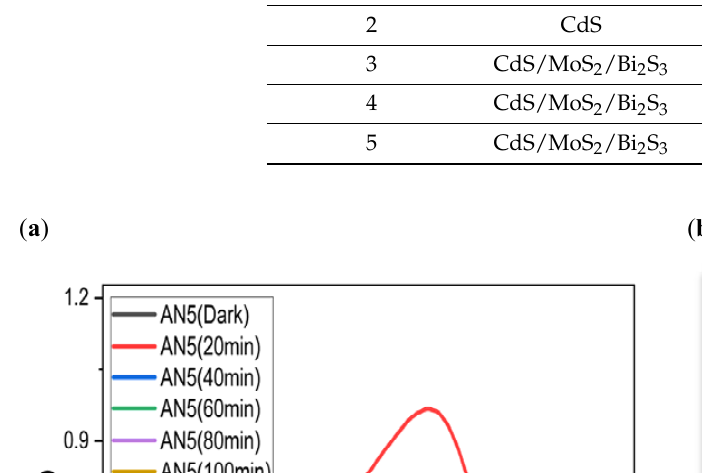
Table 1. Degradation %age efficiency of synthesized materials. Sr. No.